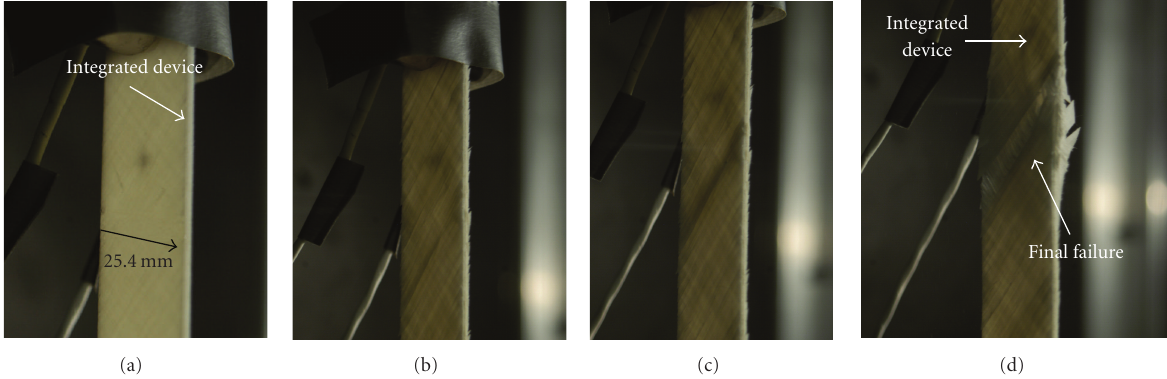
] samples with integrated dummy microprocessor, sample width 25.4 mm. 5 s